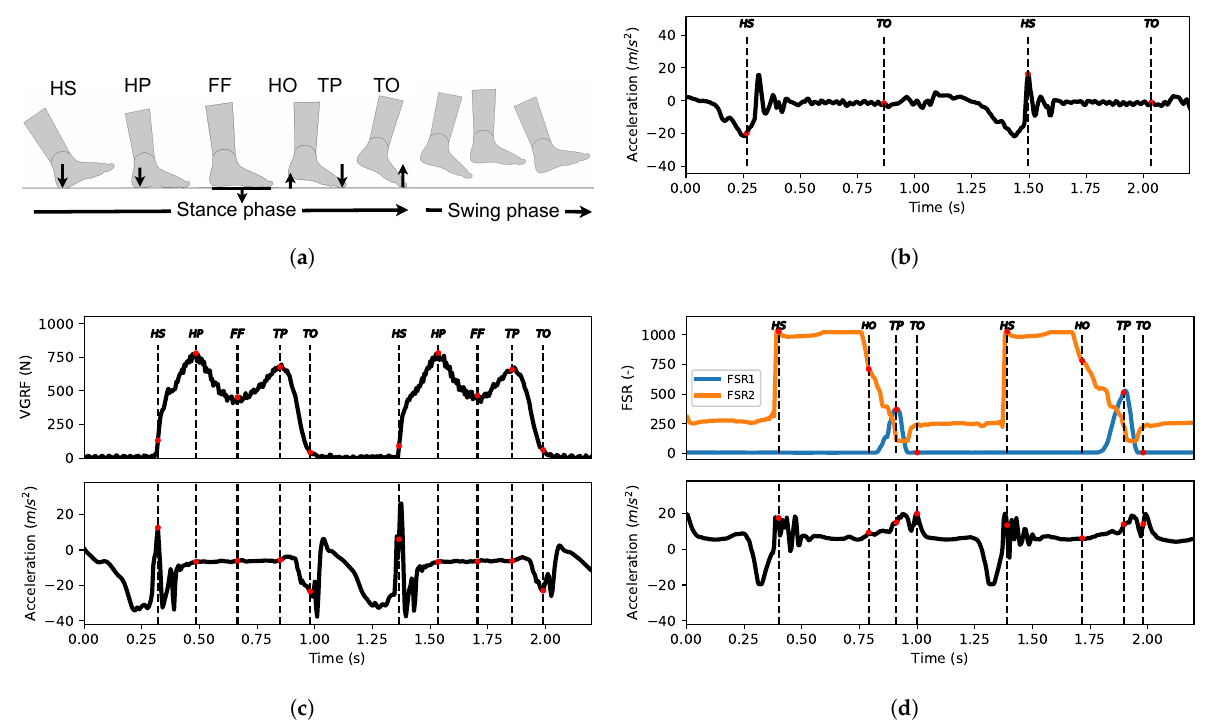
Figure 4. Event target identification process from foot pressure measurements for each three databases. Examples of foot pressure measurements, acceleration measurements, and target gait events identified in two gait cycles for each database are shown in subfigures ( b – d ). The heel strike (HS) is the first contact of the foot with the ground. The heel push (HP) is the maximum load response of the foot after the HS. The foot flat (FF) is the minimum load response of the foot in the middle of the stance phase. The heel off (HO) is the end of the heel contact on the ground in the second part of the stance phase. The toe push (TP) is the second maximum load response of the foot in the second part of the support phase. The toe off (TO) is the final contact of the foot on the ground. ( a ) Event identification; ( b ) MAREA database (acceleration of the foot position); ( c ) CIRRIS database; ( d ) UDS database. FSR1 is on the toe and FSR2 is on the